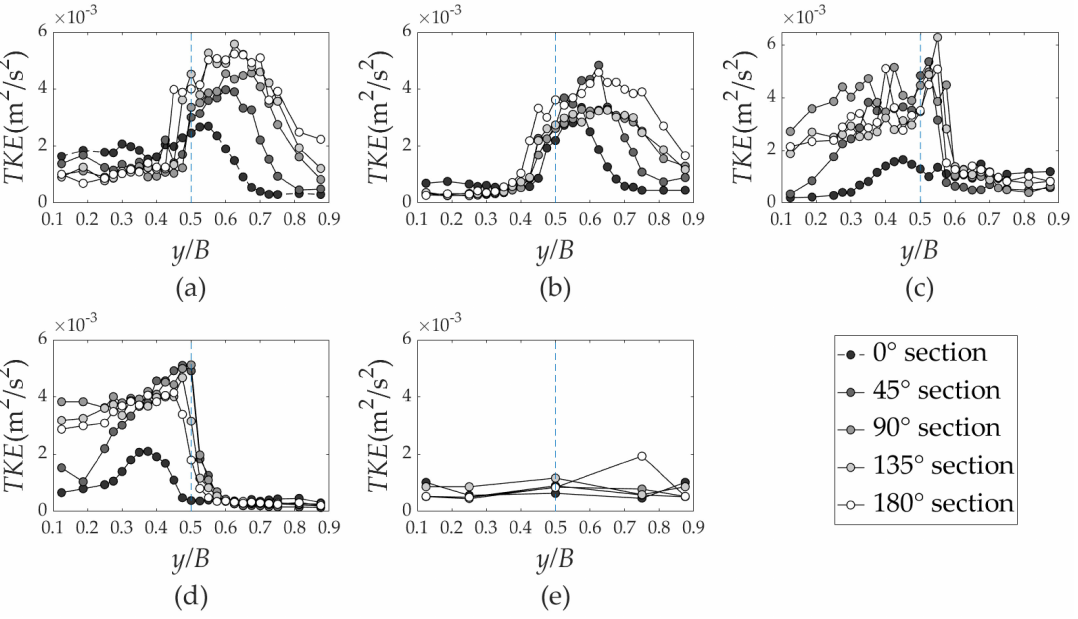
Figure 6. Turbulent kinetic energy distribution at five cross sections: ( a ) Case 1; ( b ) Case 2; ( c ) Case 3; ( d ) Case 4; ( e ) Case